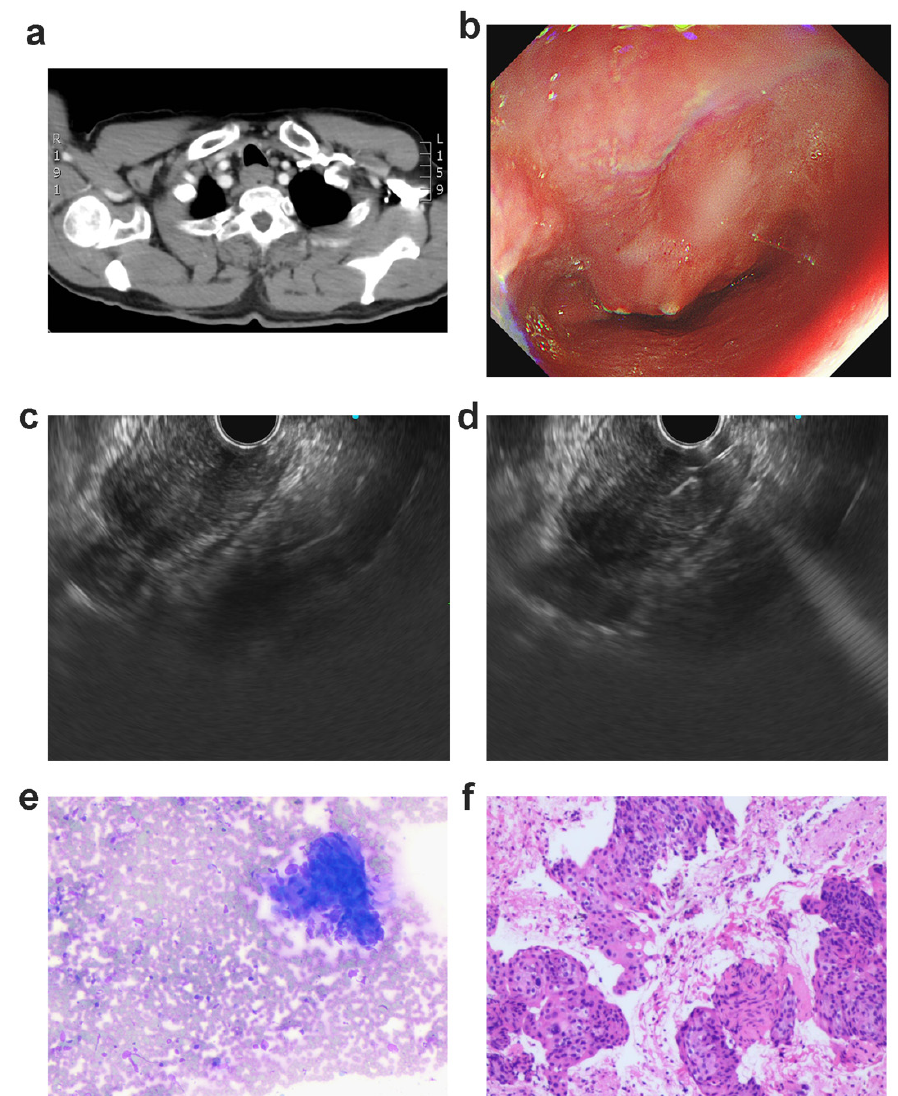
Figure 1. Medical information of patient 5: ( a ) thoracic computed tomography (CT) depicted the thickening of the esophageal wall at the thoracic entrance level; ( b ) endoscopy depicted esophageal stricture with mucosal erosion; ( c ) EUS (endoscopic ultrasound) depicted equal low-echo lesion at the upper esophagus; ( d ) EUS depicted needle puncture through the esophageal tissue; ( e ) rapid on-site evaluation depicted malignant cells; ( f ) histological studies with hematoxylin and eosin (H&E) staining showed malignant cells of poorly differentiated squamous cell carcinoma captured by EUS-FNA.